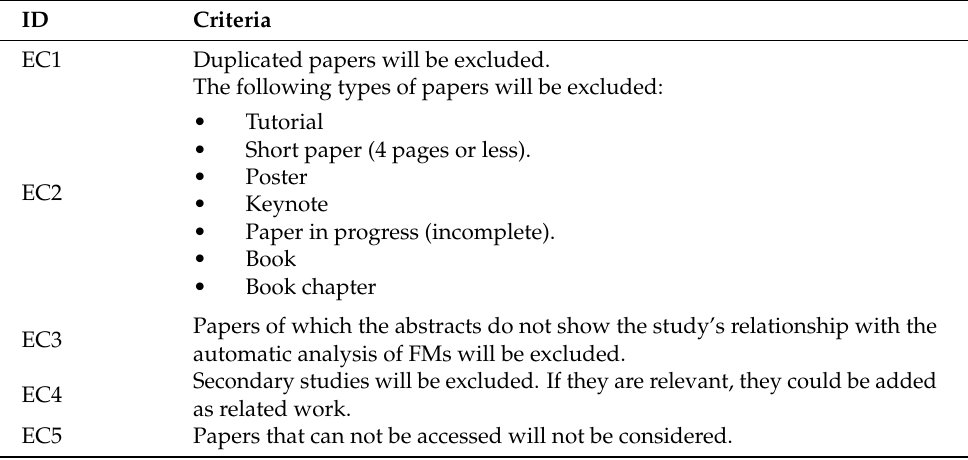
Table 9. Exclusion criteria